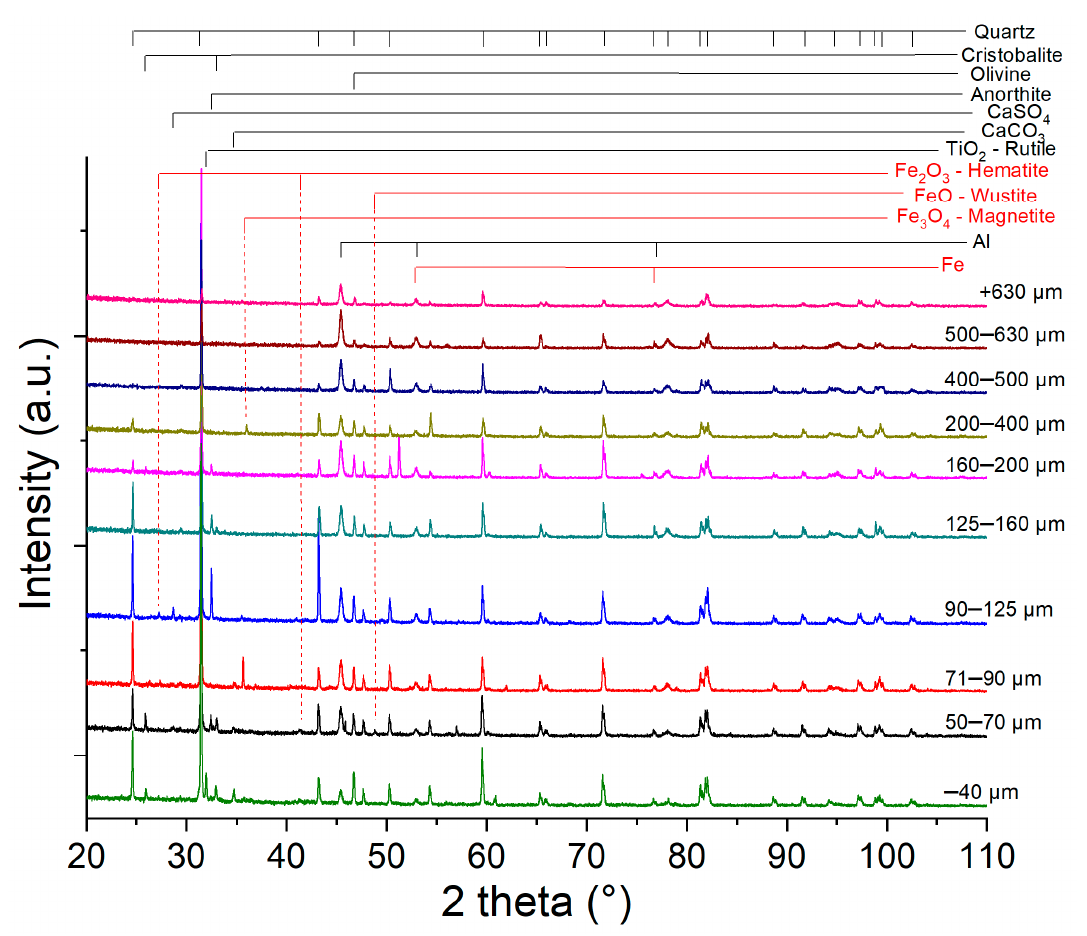
Figure 7. XRD diffraction patterns for different particle sizes of quartz sand. The X-ray diffraction indicates the complex distribution of the different compounds in the sand. Al samples contain a high amount of quartz, identified as alpha phase—P3221